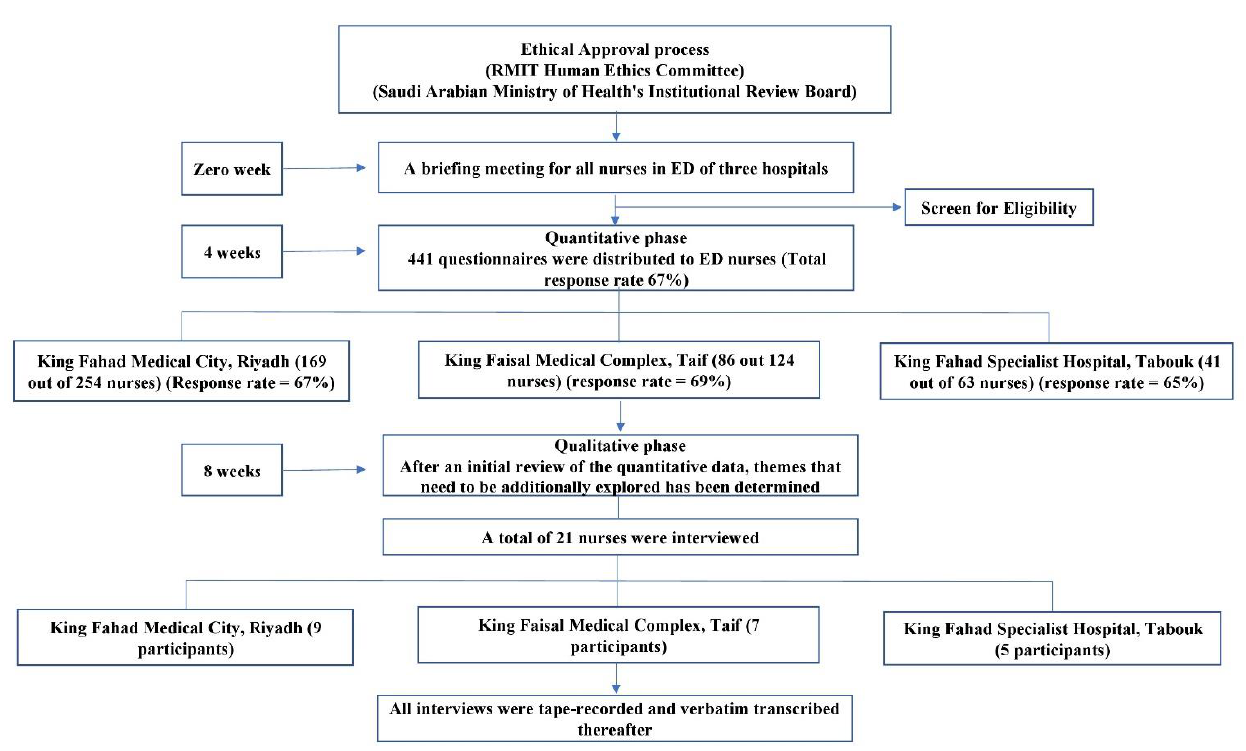
Figure 1. A schematic representation of the study protocol and data collection process.